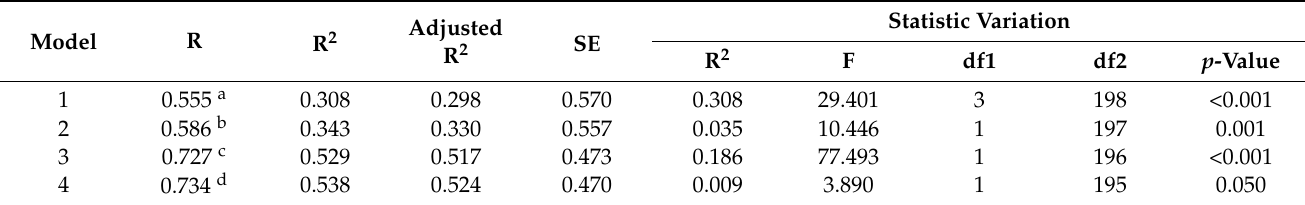
Table 4. Results of moderation effect using hierarchical regression